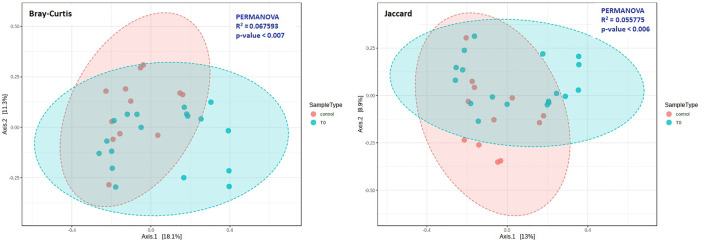
Beta diversity in COVID-19 (T0) and Control groups. Principal coordinate analysis (PCoA) plots were performed by the Bray-Curtis (left) or the Jaccard (right) distance measures. Statistical significance was assessed by PERMANOVA. In both cases we found a significant result (Bray-Curtis: p = 0.007; Jaccard: p = 0.006), and analysis confirmed that the distance between groups was dependent on the relative abundance of taxa rather than on the type.